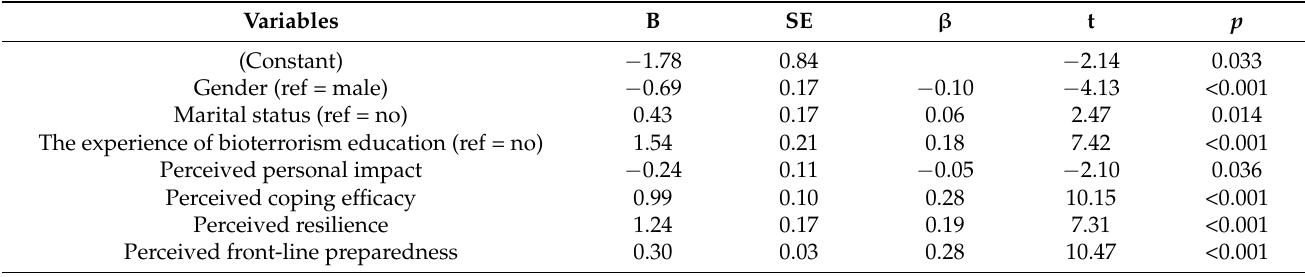
Table 4. Factors influencing bioterrorism preparedness ( N =